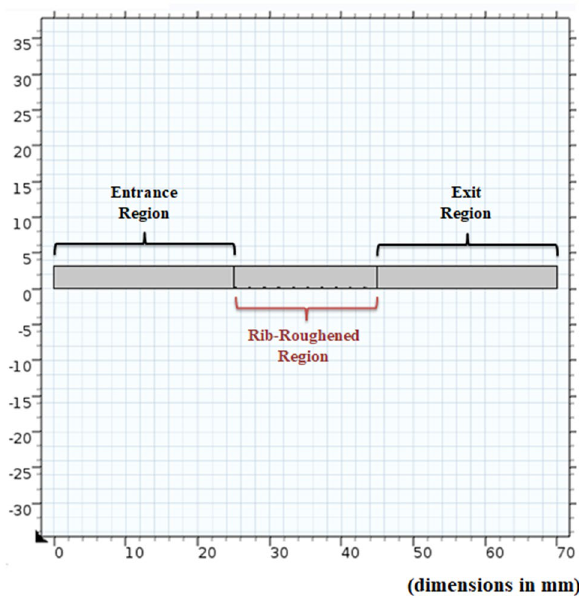
Fig. 5 Boundary conditions for